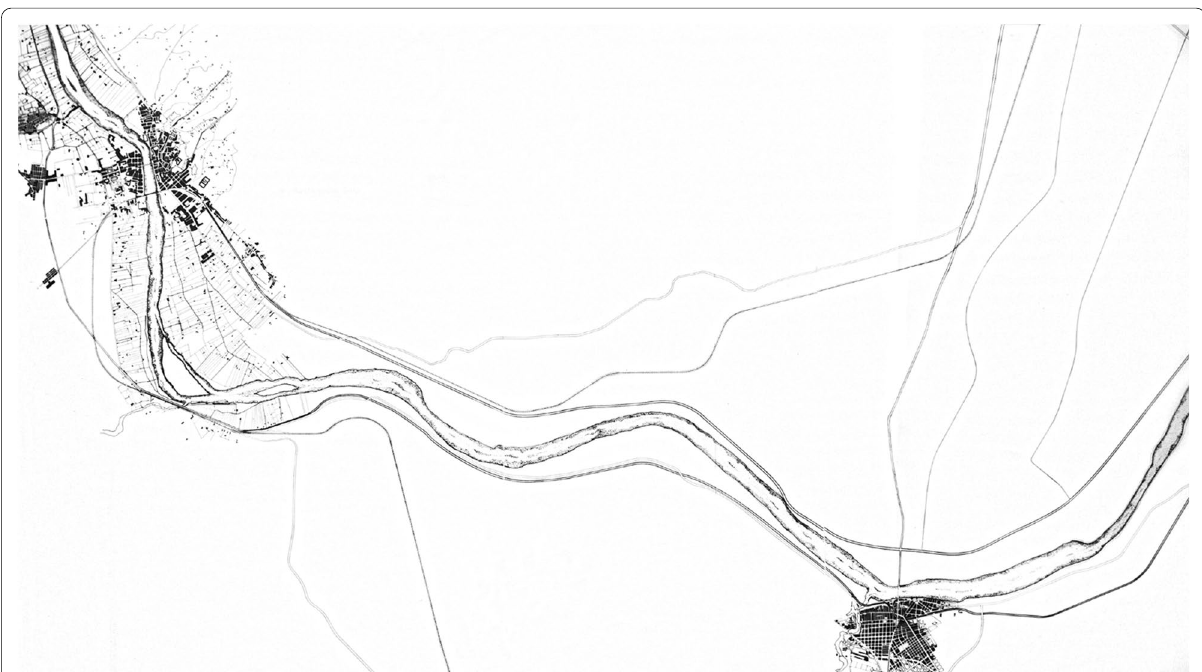
Fig. 1 Solà-Morales. ‘La forma d’un país’. Baix Ebre. Original scale: 1/10.000. Drawn in 1976. Source: Solà-Morales M (ed) (1981)